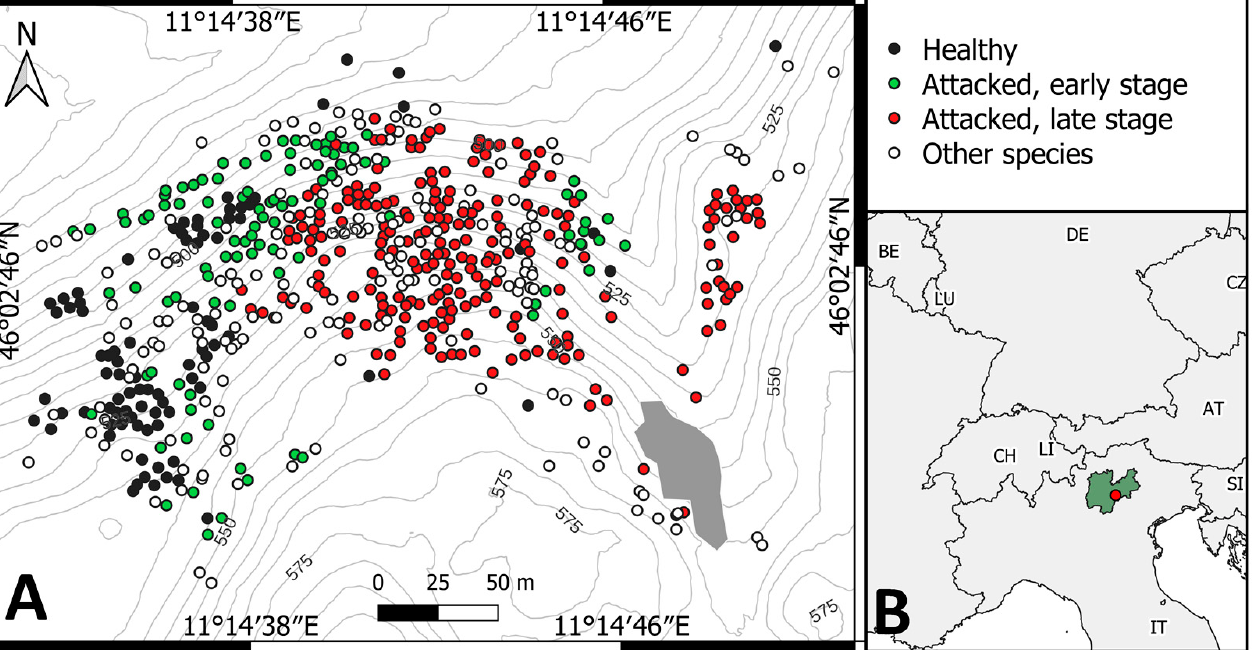
Figure 1. In panel ( A ): field data position. Each dot represents a tree measured in the field. The grey area on the bottom-right part is an area where a windthrow event happened. The lines are the contour lines spaced by 5 m. In panel ( B ), the location of the study area (red dot) and of the Province of Trento (green area) in Italy. Table 1. Summary of the trees measured in the field. Species Health Status Number of Trees Picea abies (L.) Karst. Betula pendula Roth Carpinus betulus L.